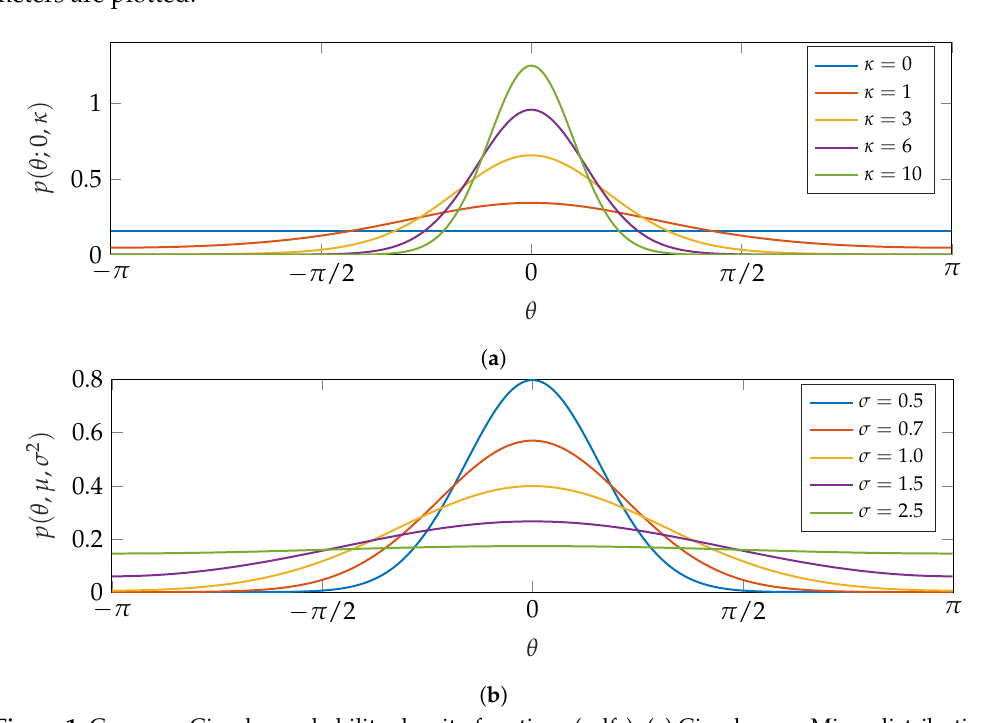
Figure 1. Common Circular probability density functions (pdfs). ( a ) Circular von Mises distribution for multiple values of κ . ( b ) Wrapped normal distribution for multiple values of σ